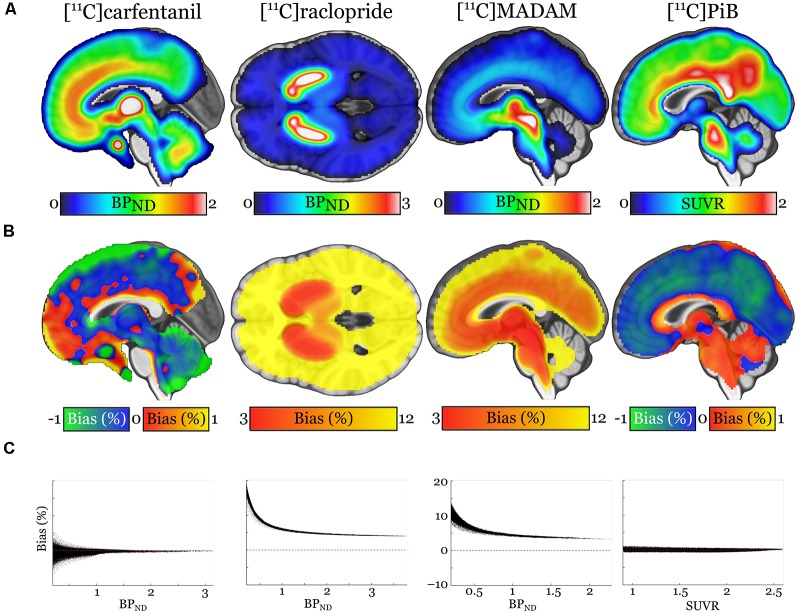
(A) Visualization of the outcome measure distributions for each tracer. (B) Maps visualizing the relative biases of the Magia-derived outcome measures compared to the averages obtained by manual reference region delineation. The manual method is here presented as the ground truth, because the manual outcome for each scan is an average over five individual estimates, while the Magia result relies on a single estimate. (C) Associations between the outcome measure magnitude and relative bias.